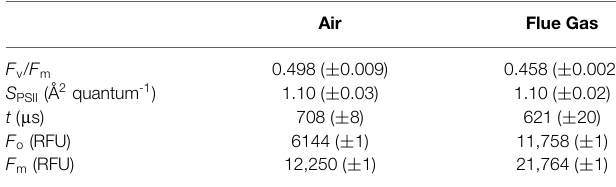
TABLE 2 | Maximum photochemical efficiency of PSII ( F v / F m ), functional absorption cross section ( S PSII ), rate of PSII re-oxidation ( t ), minimum ( F o ) and maximum ( F m ) fluorescence measured in the dark for Heterosigma akashiwo grown on air (control) or simulated flue gas (treatment) .